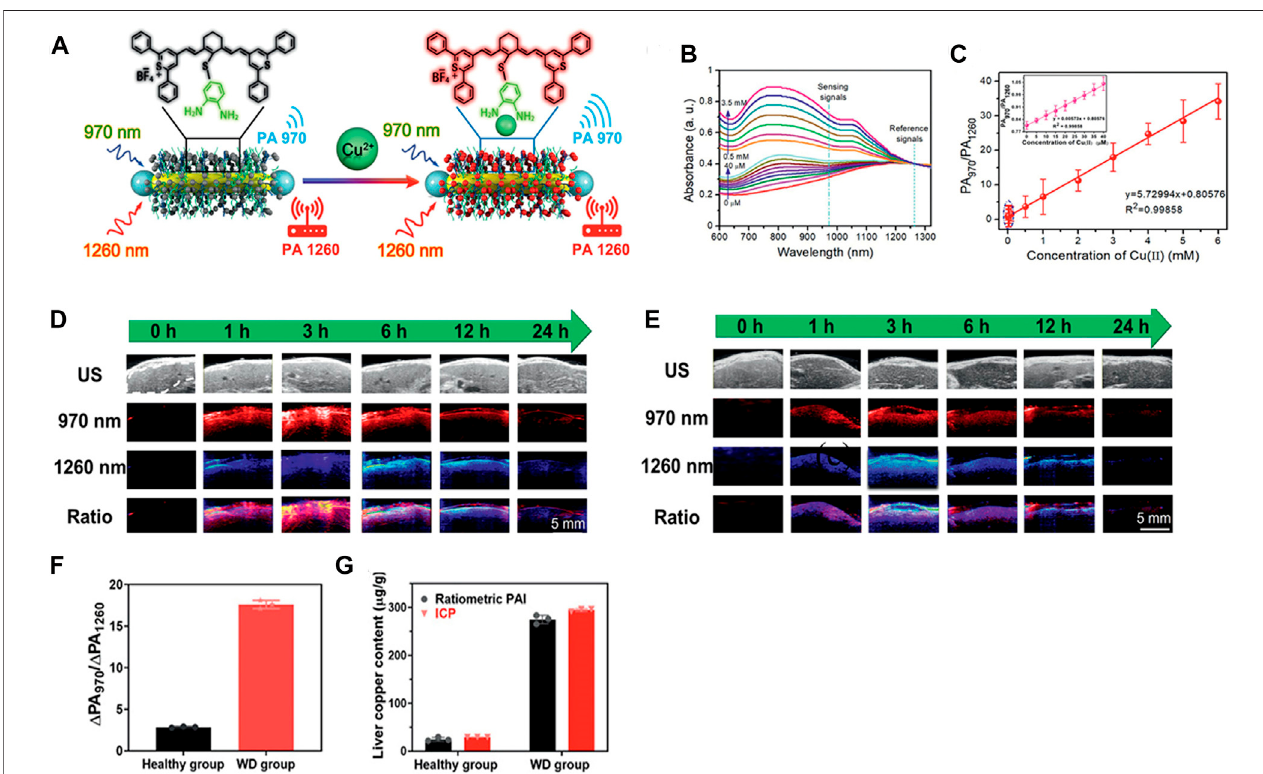
FIGURE 9 | Cu 2+ -responsive ratiometric NIR PA imaging. (A) Illustration of design of Cu 2+ -responsive ratiometric photoacoustic probe (AuNR-Pd@PIR970/ PEG). (B) UV-vis spectrum of nanoprobe in different concentration of Cu 2+ . (C) PA 970 /PA 1260 signal ratios of nanoprobe measured under various concentration of Cu 2+ . (D) Ultrasonic (B-mode) and PA images of mice liver with WD and (E) healthy mice. (F) Corresponding PA970/PA1260 value of WD and healthy group. (G) Liver Cu 2+ contents measured by liver biopsy and ratiometric PA imaging of healthy and WD mice (reproduced from (Fu et al., 2021) with permission from Wiley-VCH